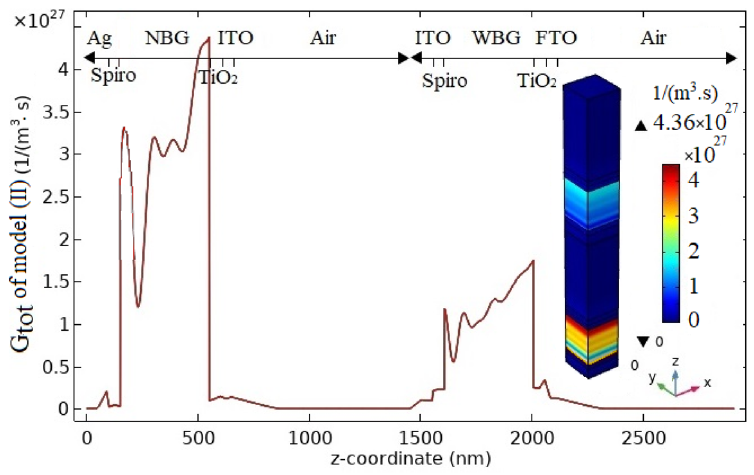
Figure 6. The generation rate profile of charge carrier related to case (II).